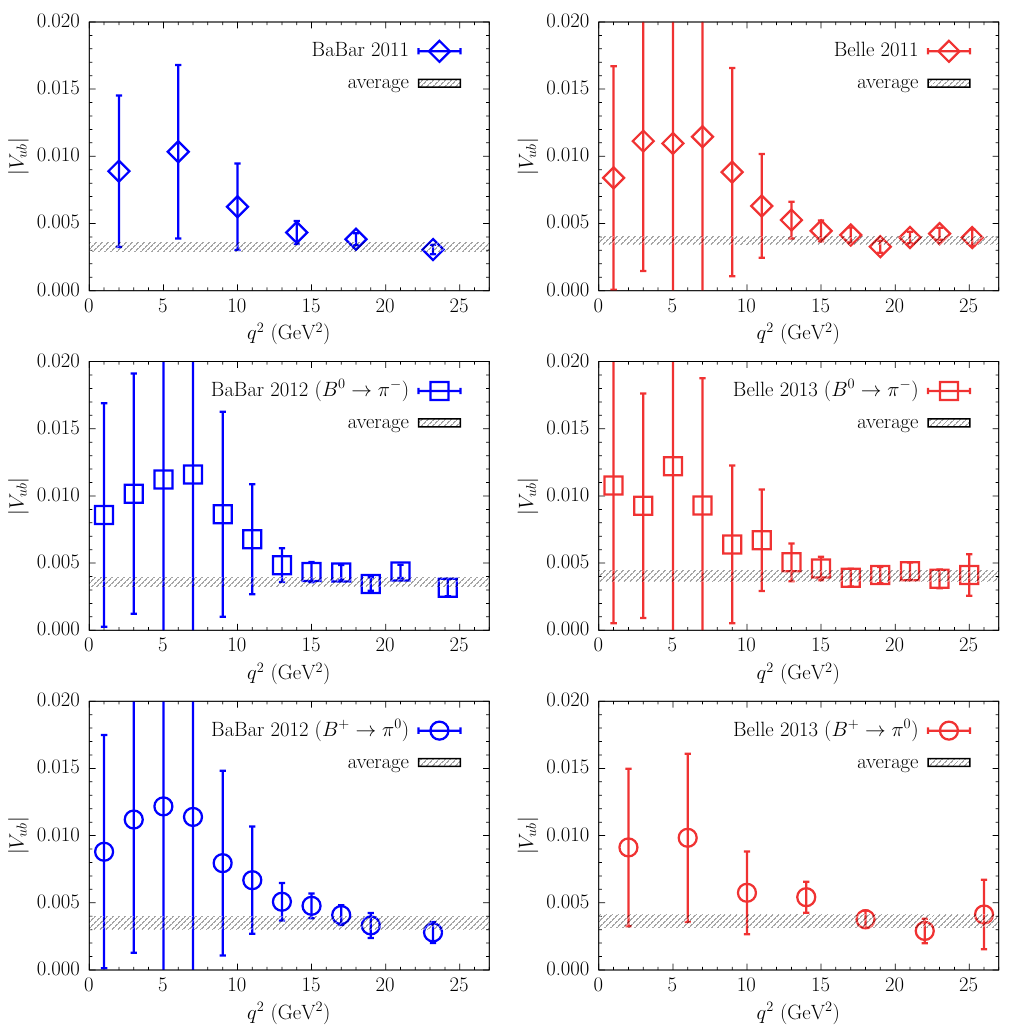
Figure 4 . Bin-per-bin estimates of | V ub | obtained using eq. (3.12) for each of the six experiments of refs. [35–38] specified in the insets of the panels as a function of q 2 . The theoretical DM bands of the FFs correspond to the use of the combined LQCD data of table 1 as inputs. The black dashed bands represent the correlated weighted averages (3.13) for each experiment, shown in table